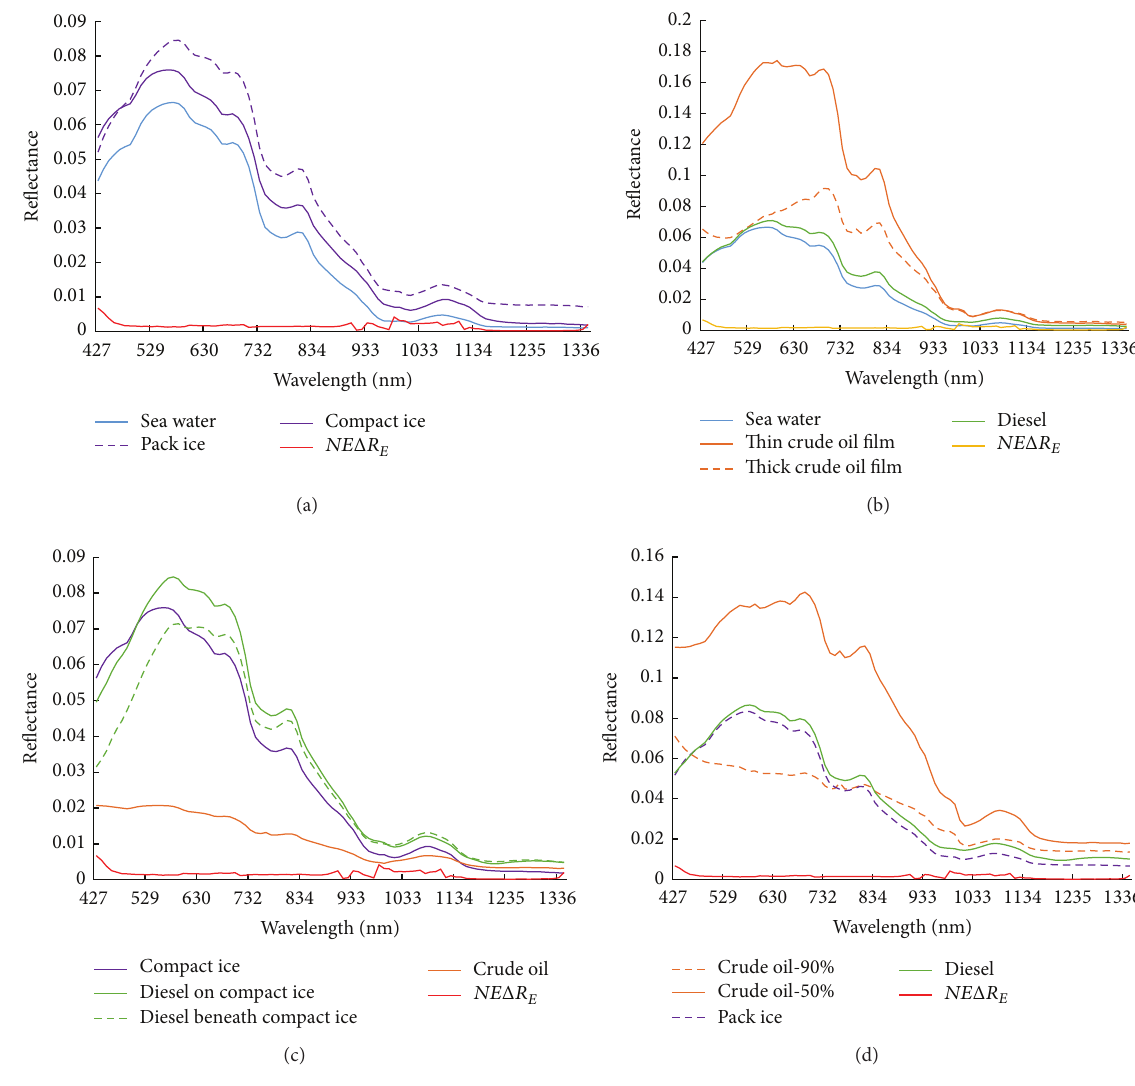
Figure 4: Simulated reflectance spectra on the